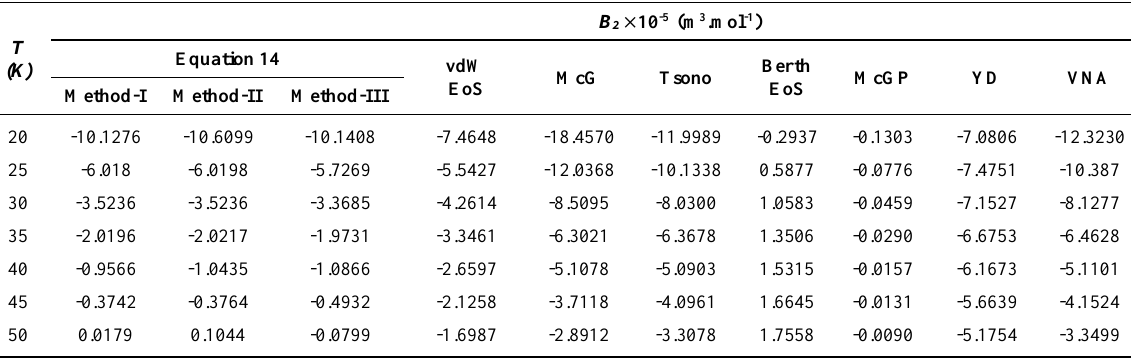
Table 5. Second virial coefficient of